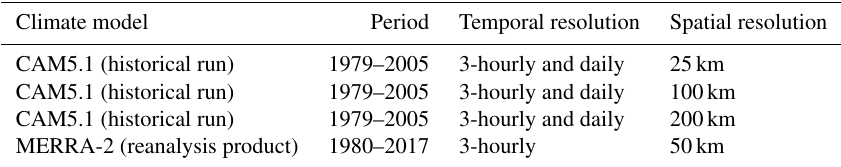
Figure 1. Sample images of atmospheric rivers – long filamentary structures reaching the west coast of the United States: (a) landfall in a region of northern California; (b) landfall in a region of Washington state. Shown is integrated water vapor (kgm − 2 from a simulation of version 5 . 1 of the Community Atmosphere Model (CAM5.1). Table 1. Data sources (climate model and reanalysis